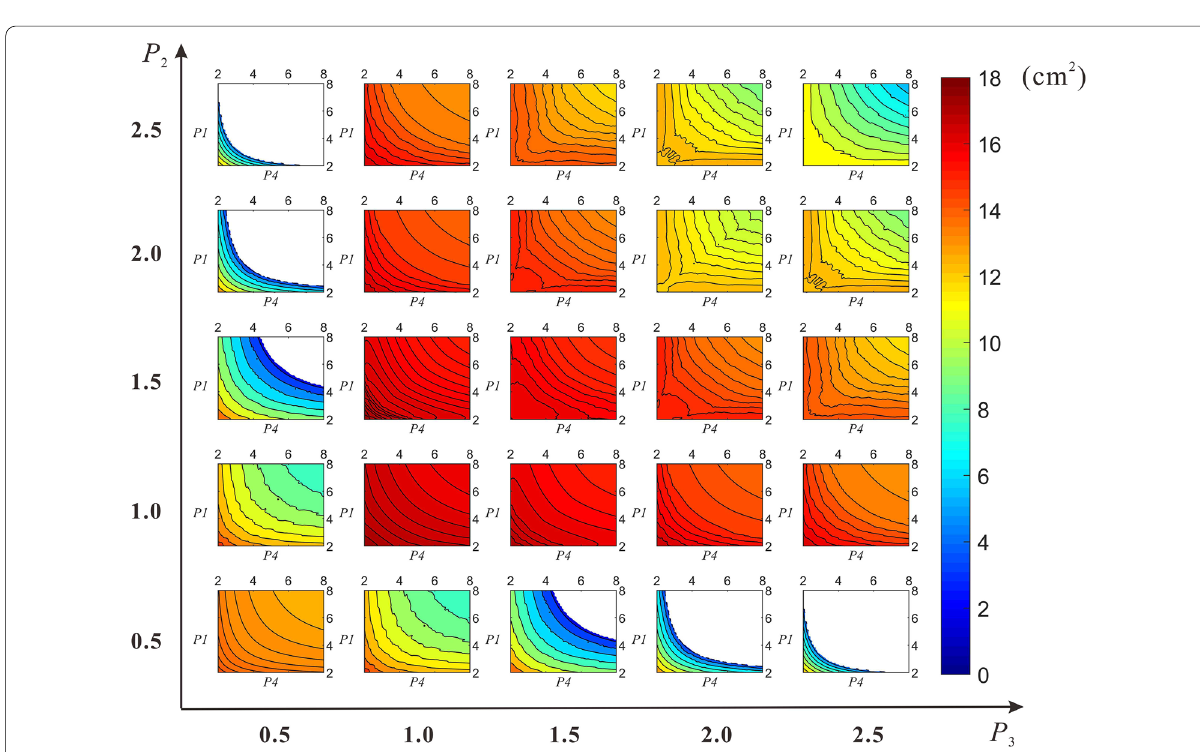
Figure 6 S ′ of the palm with different P